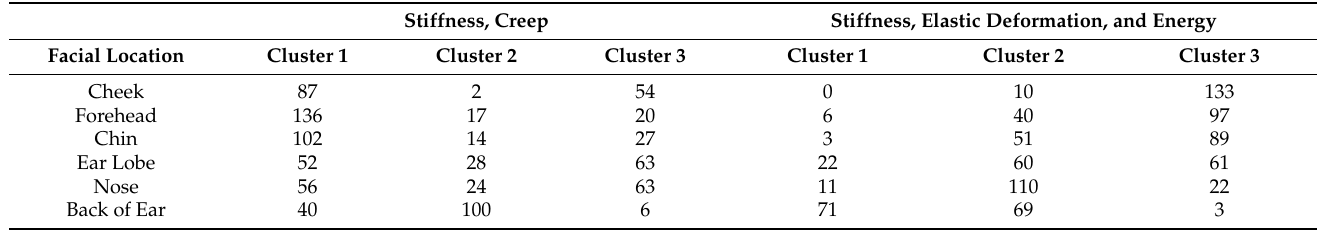
Table 5. Number of observations for each facial location per cluster for viscoelastic and stretchabil-